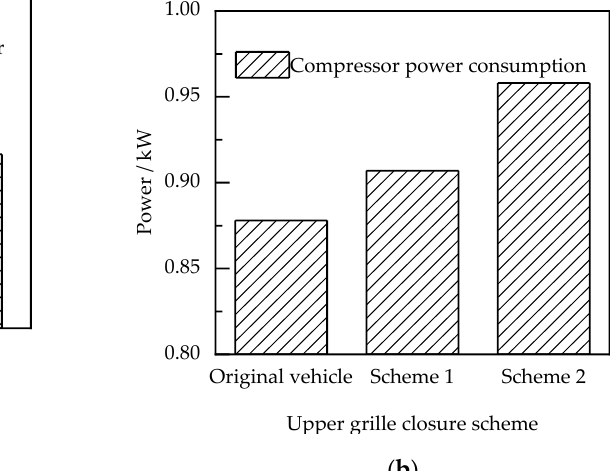
Figure 19. Comparisons of cooling capacity and power consumption of the air conditioning system under different schemes: ( a ) comparison of refrigerating capacity; ( b ) comparison of power consumption.